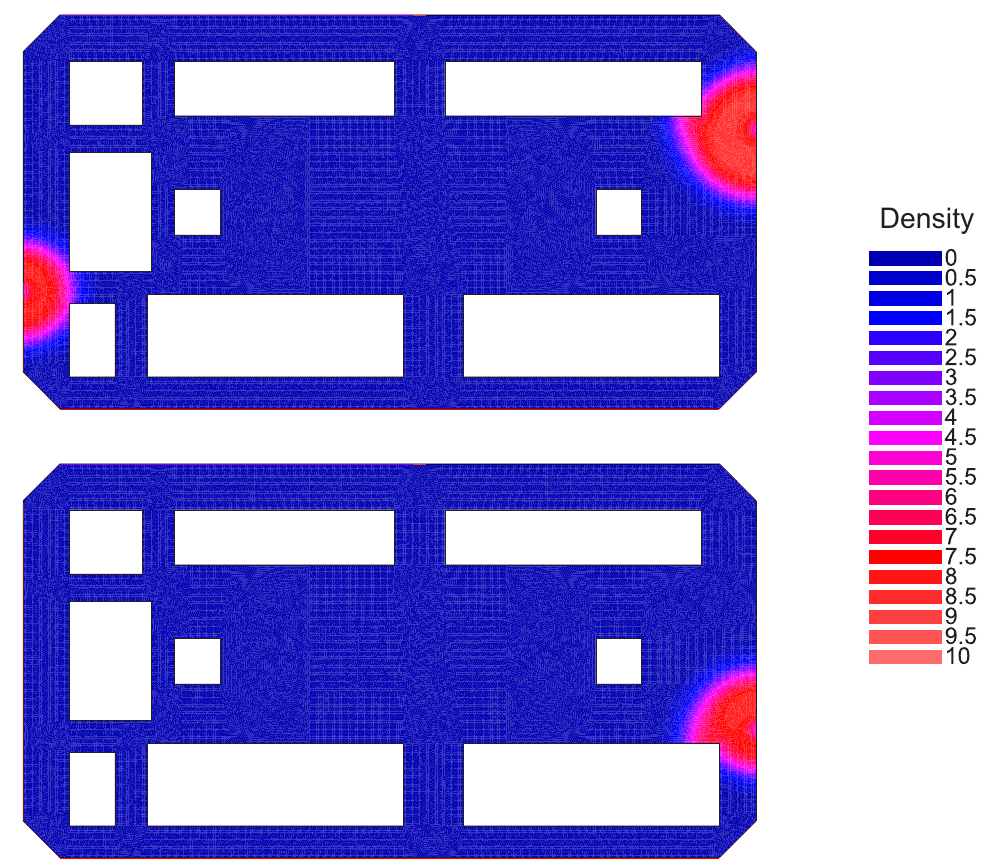
Figure 8. Case 2: Pedestrian densities ρ at final time t = 350 for the initial ( top ) and the optimal locations ( bottom